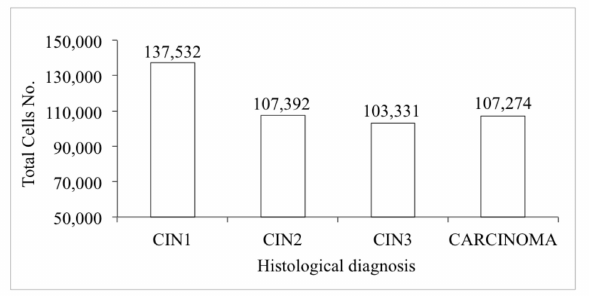
Figure 3. Estimated mean values of total cells by histology.